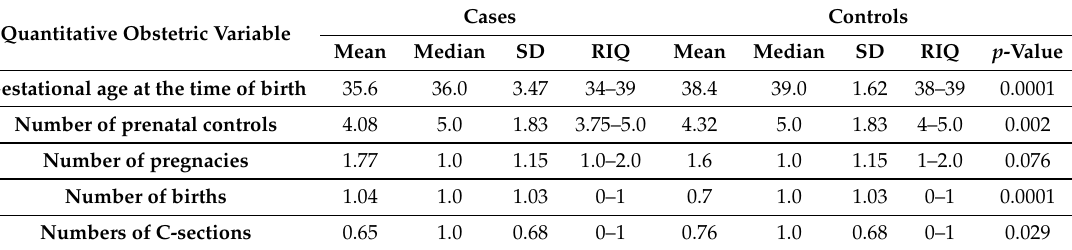
Table 8. Quantitative Obstetric variables in cases (186) and controls (369).